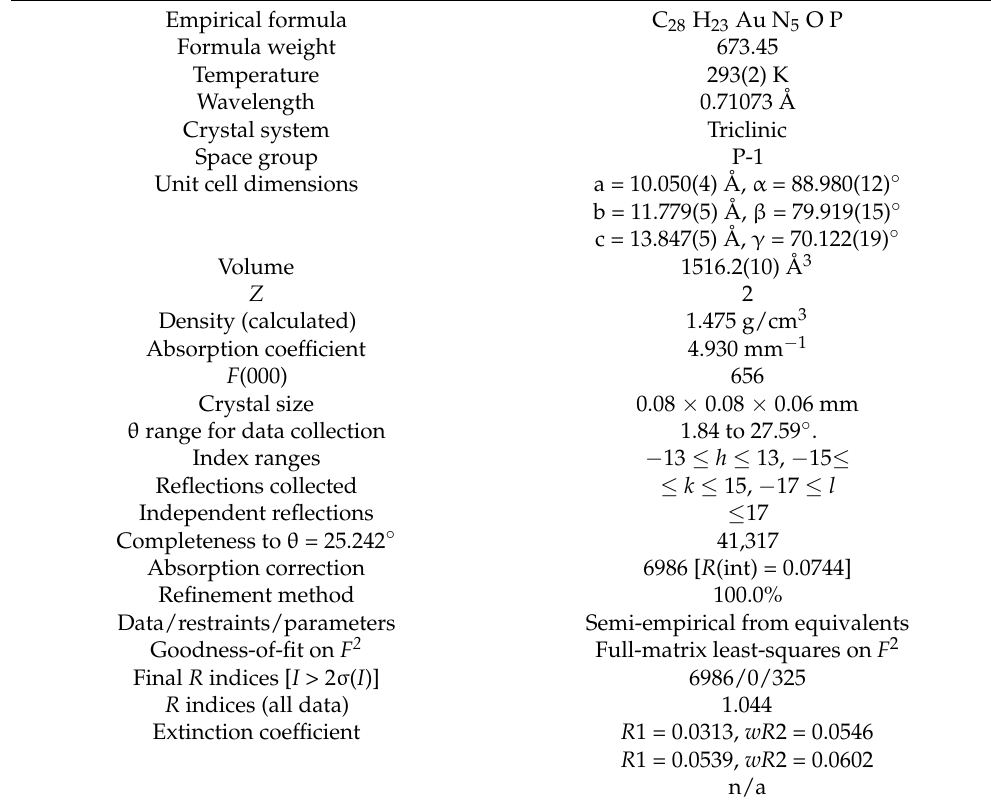
Table 4. Crystal data and structure refinement for [Au(kin)(PPh 3 )] ( 1